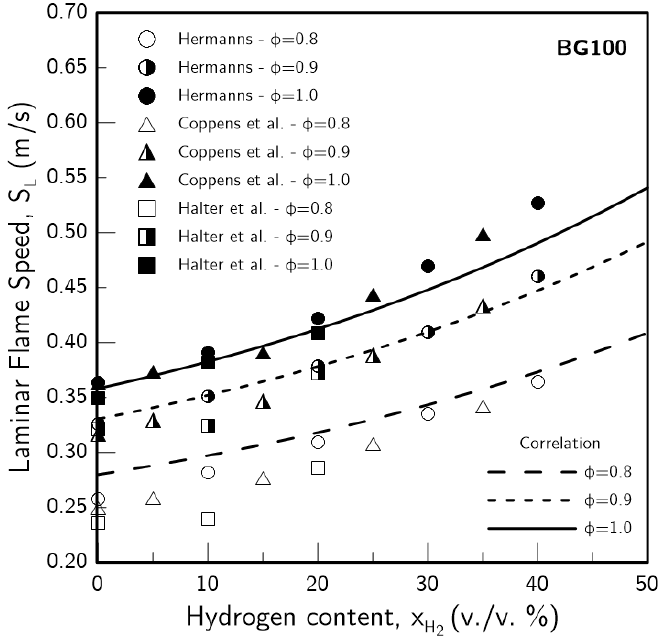
Figure 8. Laminar flame speed of H -enriched BG100/air flames. Symbols are literature results, and 2 lines are the application of the correlation of this work.